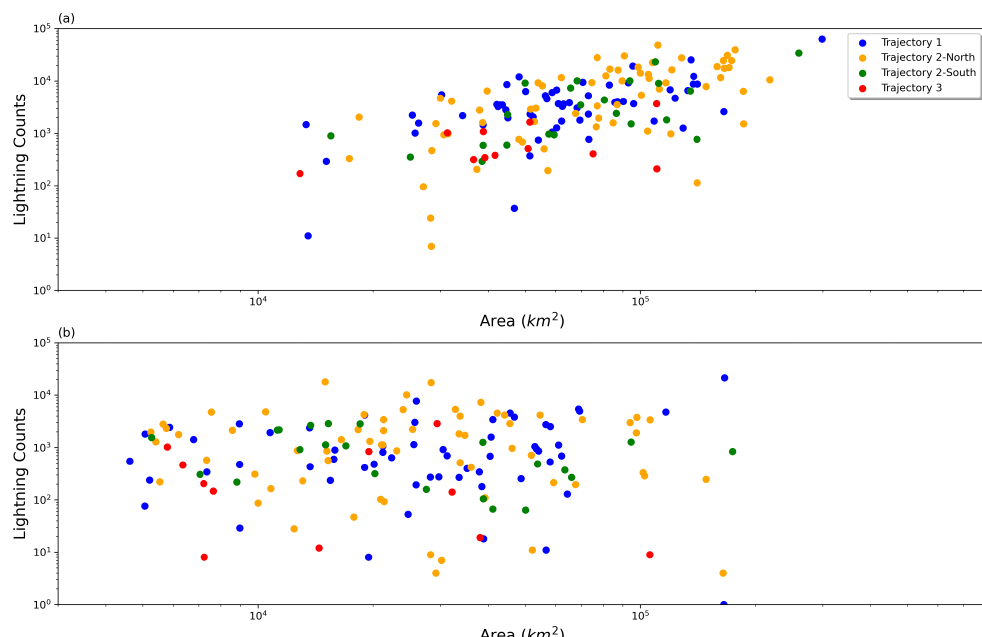
Figure 8. Scatter plot lightning count (log scale) vs. area of MCS (log scale) during the summers of 2011–2017 for all MCS Trajectories. ( a ) Stage 1 and ( b ) Stage